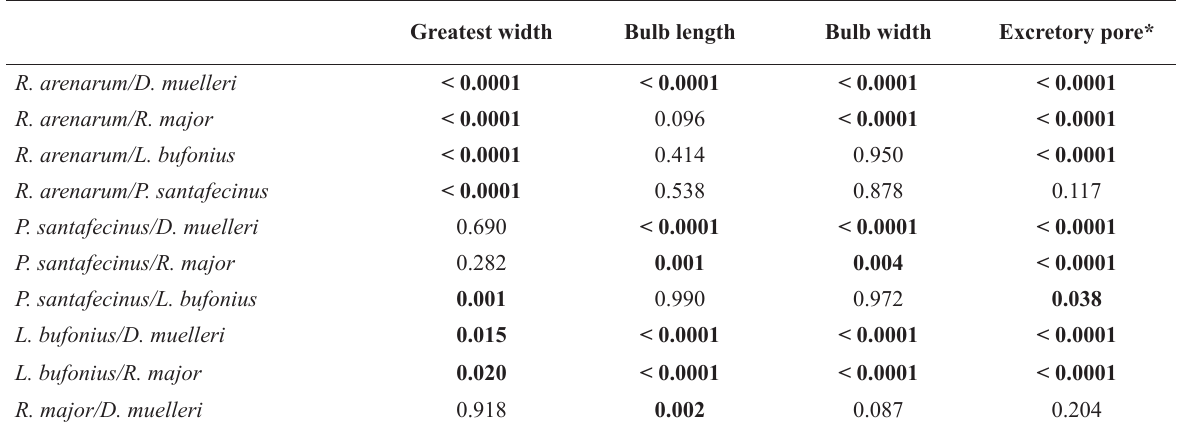
P values for pair comparisons of morphological features of females of A. hylambatis from different amphibian hosts in Argentina. Significant values in bold.